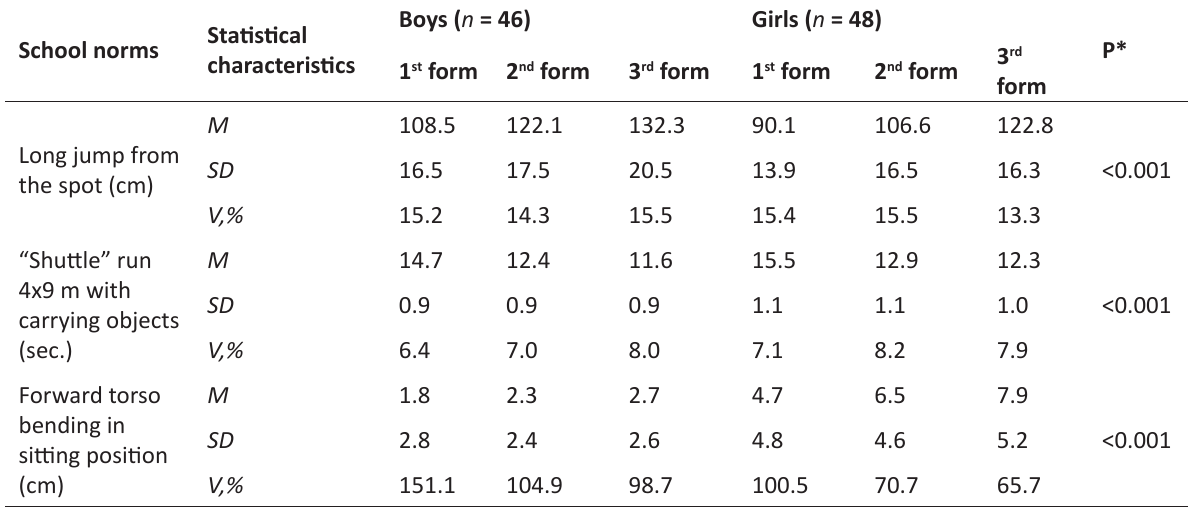
Table 1. Comparative characteristics of pupils’ physical fitness in period from 1 st to 3 rd forms (n = 94)